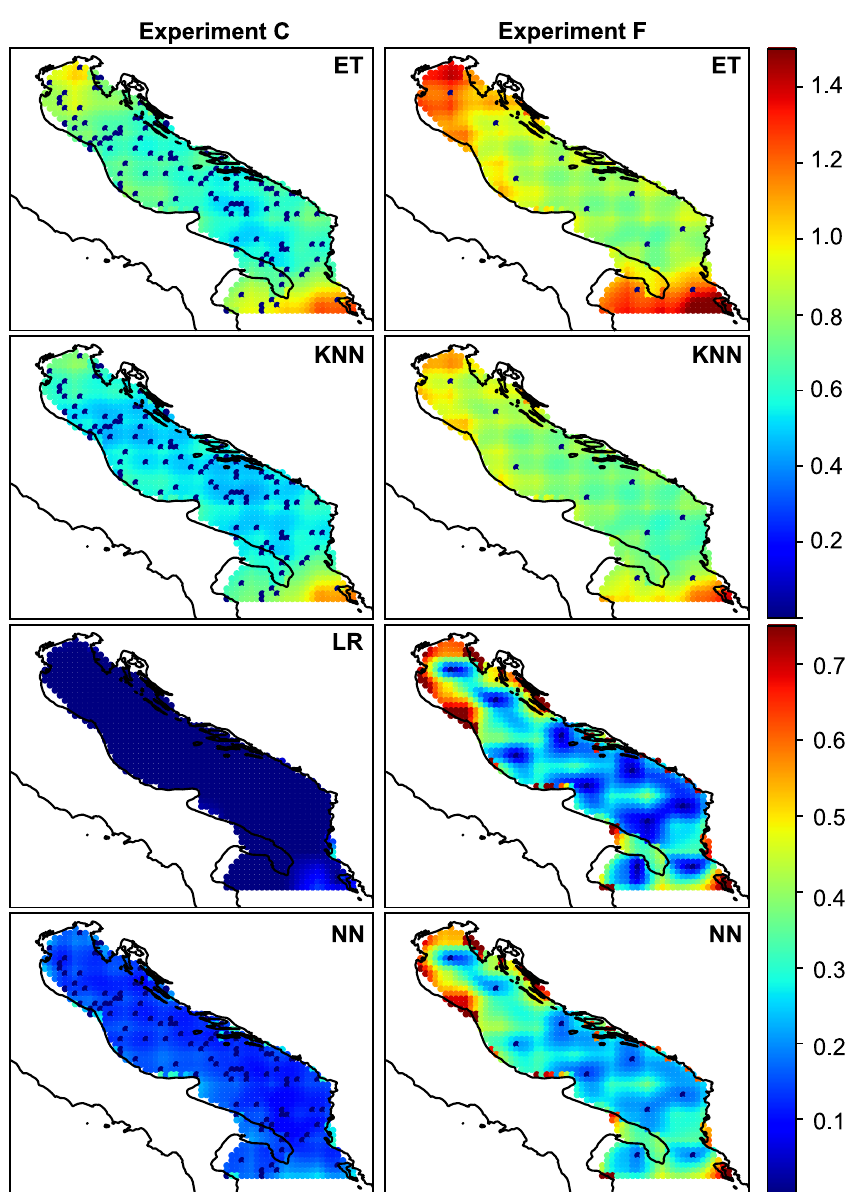
Figure 6. Spatial distribution of amplitude variance for randomly distributed 110 sensors— experiment (c)—and for intelligent selection of the 10 sensors experiment